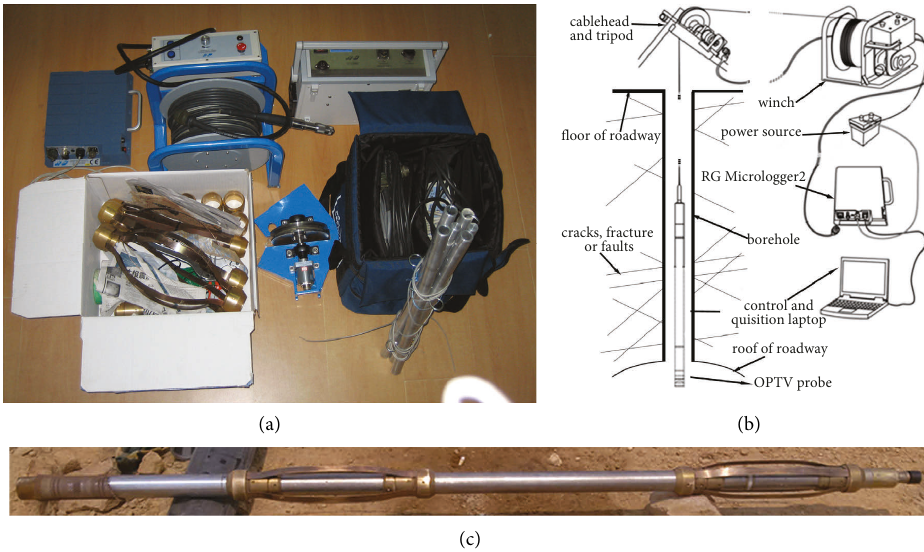
Figure 7: Equipment arrangement. (a) Test equipment. (b) Schematic diagram of equipment arrangement. (c) OPTV probe.